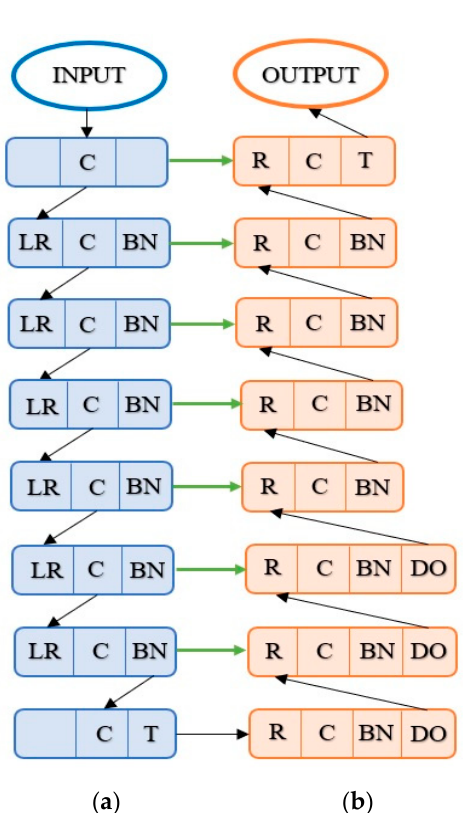
Figure 4. The architecture of the generative adversarial network (GAN) generator: ( a ) the encoder; ( b ) the decoder. R—rectified linear unit, LR—leaky rectified linear unit, C—convolutional layer, BN—batch normalization, DO—dropout layer, and T— tanh function.